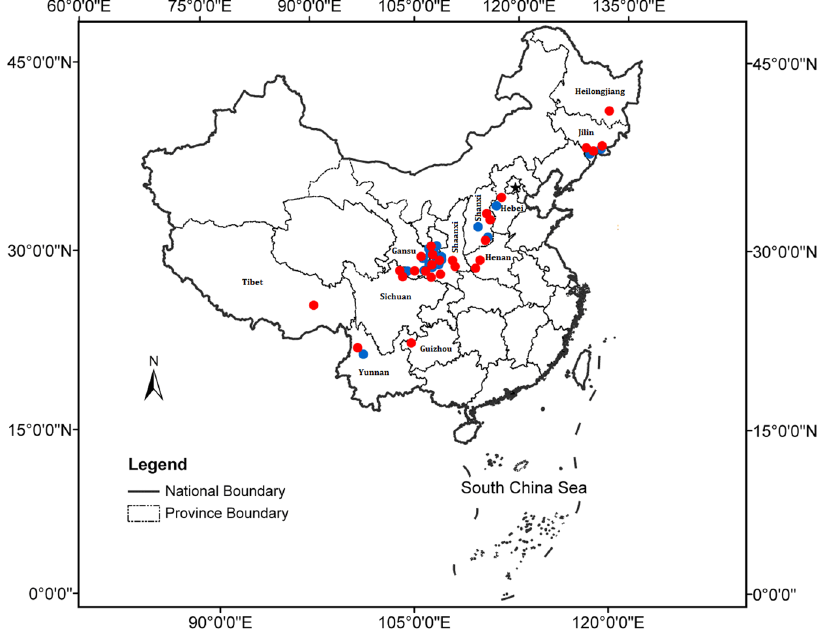
Figure 4. Map of China showing successful sampling sites of P. umbellatus . Red circles: the P. umbellatus samples from which Armillaria were isolated; Blue circles: the P. umbellatus samples from which Armillaria were not successfully isolated. The map was generated using ArcGIS 9.3 (ESRI, Redlands, CA, USA; http://www. esri.com).